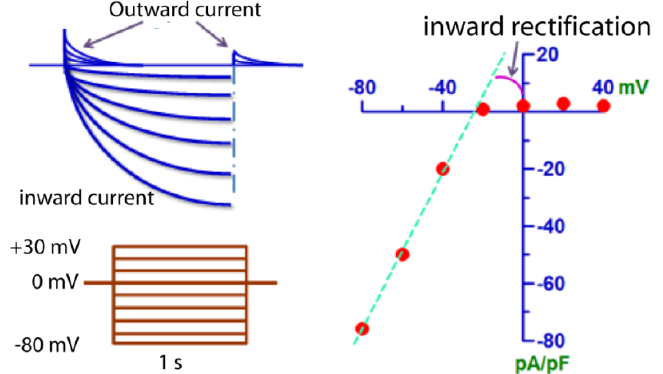
Figure 1. Biophysical properties of ClC-2 channels in mouse cardiomyocytes. ( Left ) A typical example of the currents mediated by ClC-2 channels elicited by the voltage protocols shown in the inset. Cells were voltage clamped by stepping from a holding potential of 0 mV to various potentials between − 80 and 30 mV in 10 mV increments for 1 s, following by 400 ms steps to 0 mV. The pipette solution contained 120 mM N -methyl- D -glucamine-Cl, 5 mM MgATP, 0.1 mM NaGTP, 5 mM EGTA, 5 mM HEPES; pH 7.4, and 300 mOsm. The , 1 mM CaCl , 2 mM BaCl , 10 mM bath solution contained 102 mM NaCl, 1 mM MgCl 2 2 2 CsCl, 10 mM HEPES, 10 mM glucose; pH 7.4, and 300 mOsm. Hyperpolarization elicits Cl − efflux to mediate large inward currents; in contrast, depolarizing pulses provoke Cl − influx to mediate small outward currents. ( Right ) The current-voltage (I-V) relationship of ClC-2 currents. Deviation of actual currents from the theoretical linear regression line indicates the inward rectifying property of ClC-2